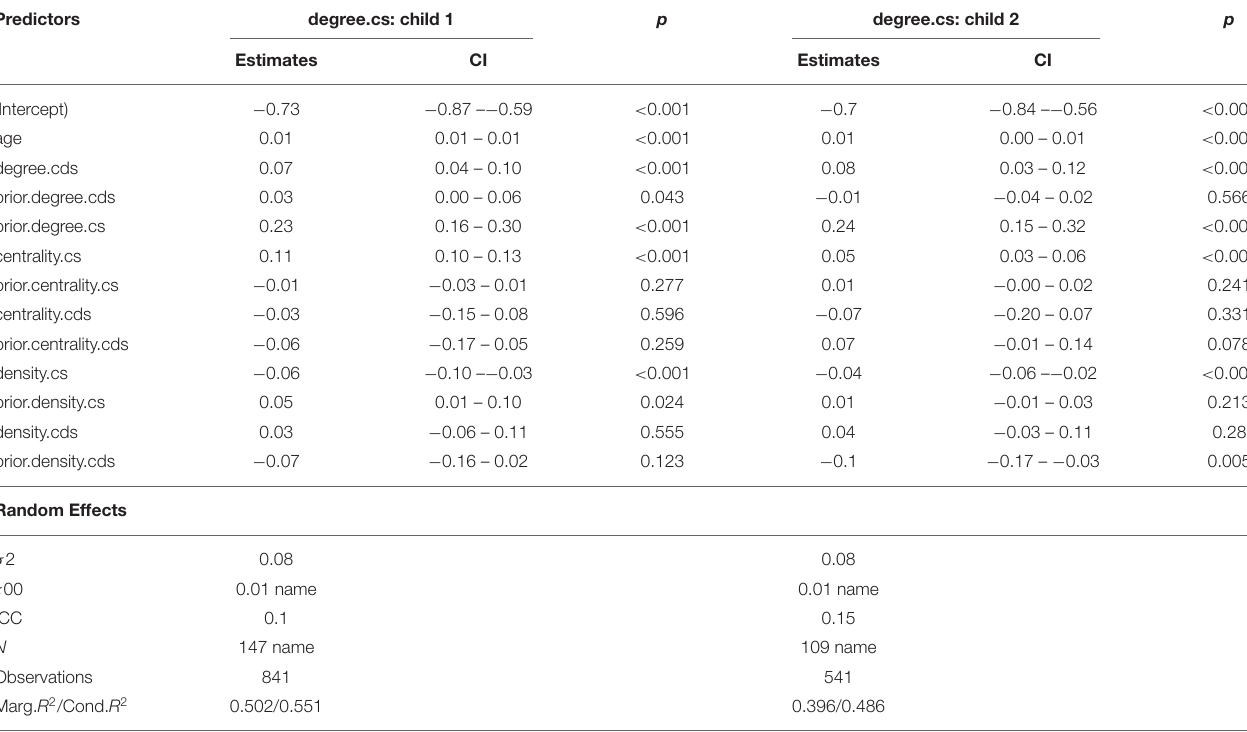
TABLE 6 | Linear mixed model: CS node degree.